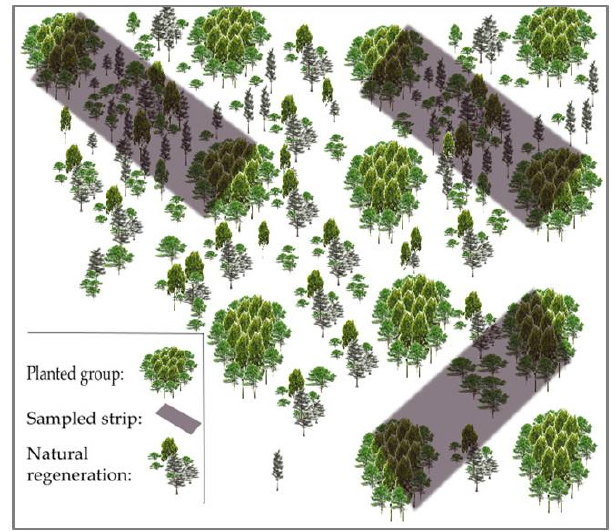
Figure 2. Sampling scheme inside a 40 × 40 m plot in a group planting. In each stand, three such plots were installed for the purpose of sampling. After that, three subplots (or strips) were installed in each 40 × 40 m plot to survey the planted oaks and trainer trees inside the groups as well as natural regeneration between the groups.